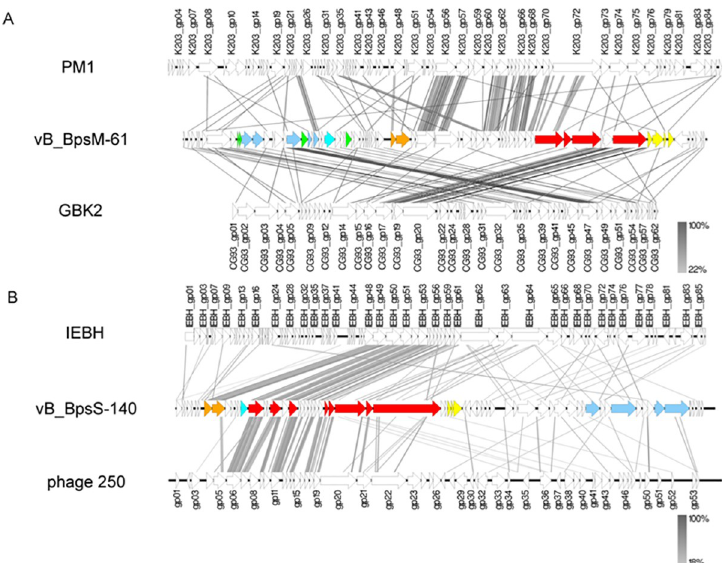
Fig 3. Genomic comparisons of vB_BpsM-61 (A) and vB_BpsS-140 (B) with related phages. Functional clusters are marked by the same color, namely DNA packaging (orange), structural components (red), lysis (yellow), regulation (green), replication (blue) and nucleotide metabolism (turquois). Synteny plot was generated with Easyfig with amino acid sequence comparison [33]. The amino acid sequence identity range is indicated by a gradient scale.